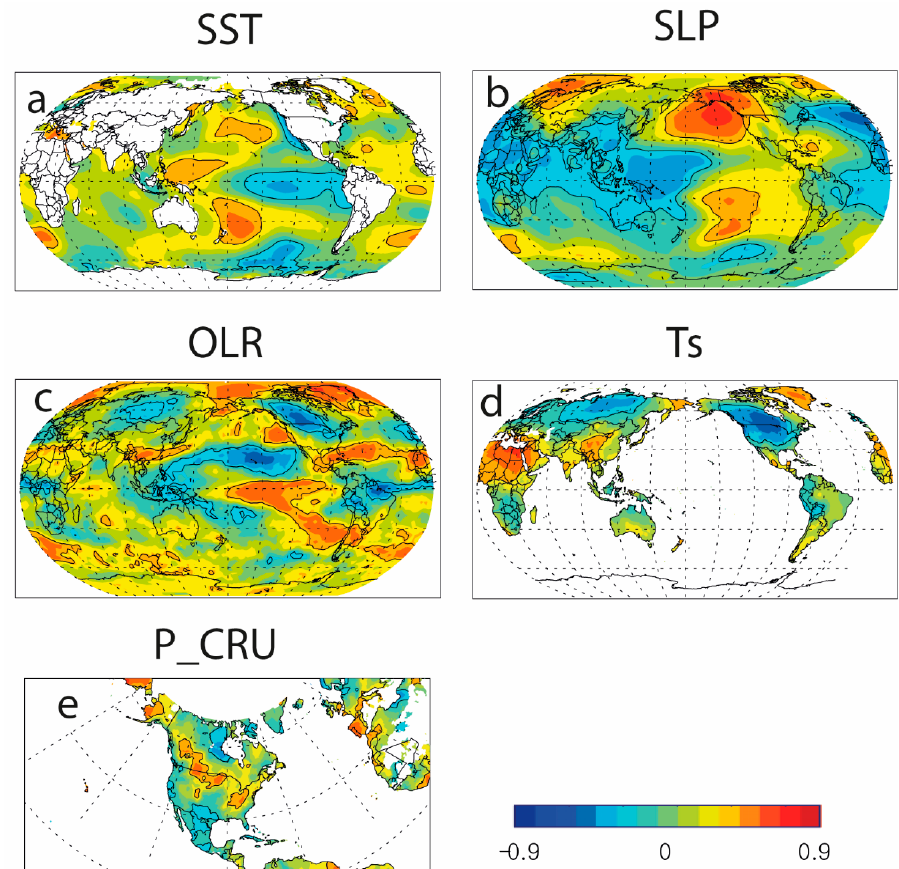
Figure 4. The 41-year (1975–2015) correlation map of the PC2 with ( a ) SST, ( b ) SLP, ( c ) OLR, ( d ) CRU surface temperature, and ( e ) CRU precipitation. Black solid lines indicate statistical significance at the 95% confidence level.